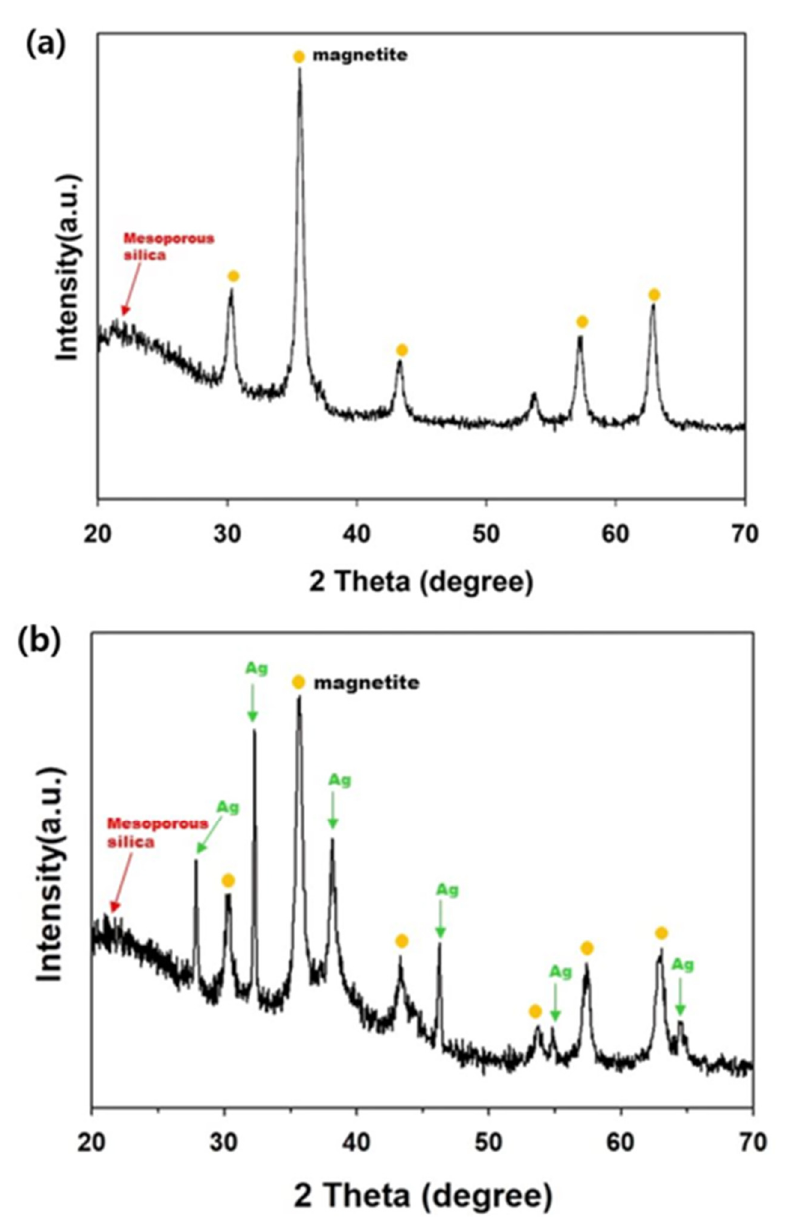
Figure 9. X-ray diffraction pattern of ( a ) mag@silica and ( b ) mag@silica-Ag. Yellow circle denotes the peaks corresponding to magnetite and the green arrows the peaks due to Ag.